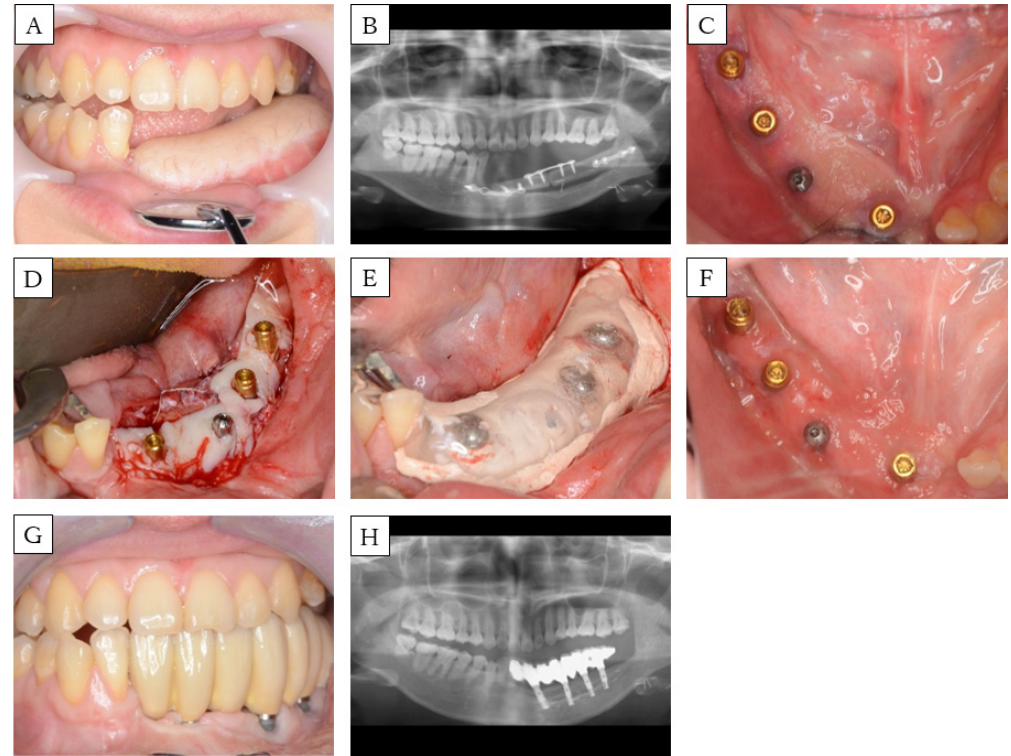
Figure 4. Case 3. ( A ) Preoperative intra-oral picture of the mandibular reconstructions with fibula- free flaps. ( B ) Panoramic radiograph of the patient before implant placement. A single-barrel fibula was placed corresponding to the mandible. ( C ) Postoperative intra-oral picture of the secondary implant surgeries. ( D ) Intra-operative picture: placement of palatal mucosa around the implant. ( E ) Intra-oral picture: a splint is fixed in with a locator abutment in combination with COE-PAK ® . ( F ) Postoperative intra-oral picture of the FGG. ( G ) Intra-oral picture and ( H ) panoramic radiograph of the patient after setting the prosthesis.